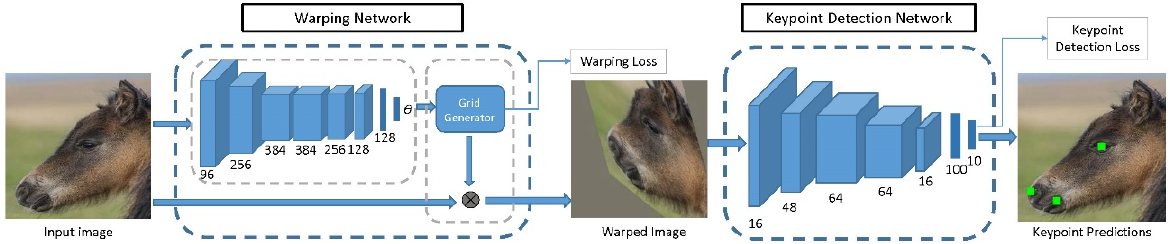
Figure 1. A deep convolutional neural network (CNN) for animal facial keypoint detection. It produces keypoint predictions for the left eye, right eye, nose, left mouth corner and right mouth corner. From [109].